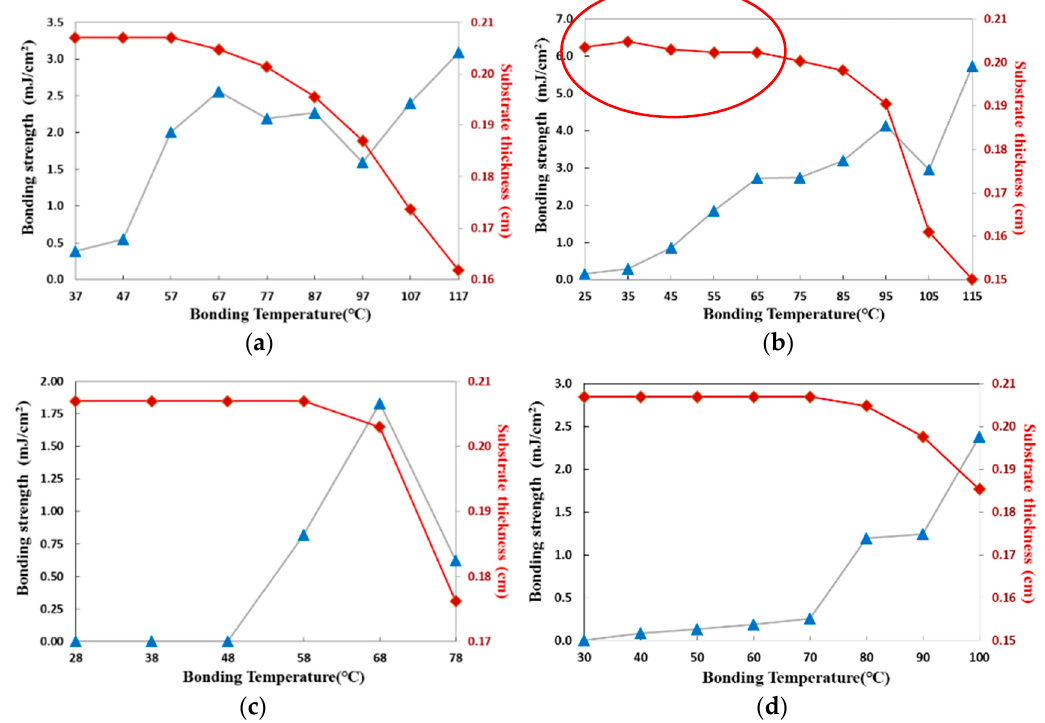
Figure 7. UV/ozone bonding strength (blue line) and substrate thickness (red line) for ( a ) CBC-1, ( b ) CBC-2, ( c ) COC, and ( d ) COP. The bonding strength values are the average of three individual measurements.